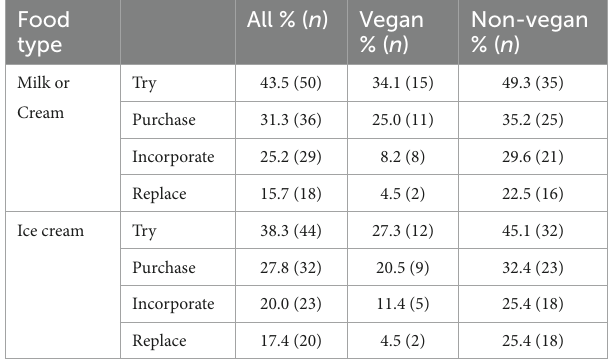
TABLE 2 Likelihood to try, incorporate, and replace milk or cream and ice cream with yeast-derived dairy